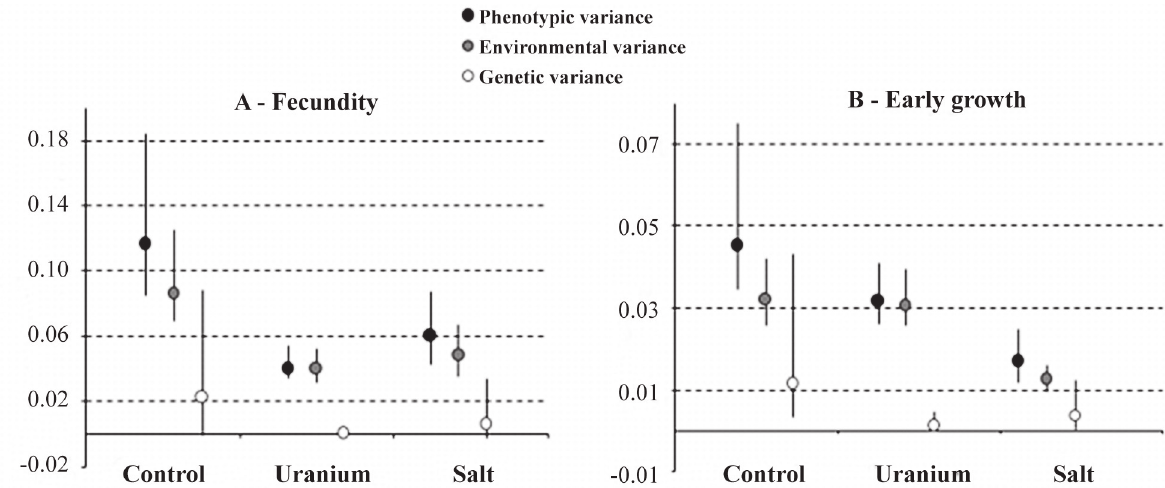
Fig 1. Trait variance estimates for C . elegans in the different environments. Variances are presented with their 95% intervals of Bayesian credibility. (A) fecundity and (B) early growth. Phenotypic variance (V P ) is split into environmental (V E ) and genetic variances (V G ). Estimates were obtained using multivariate models for different traits within the same